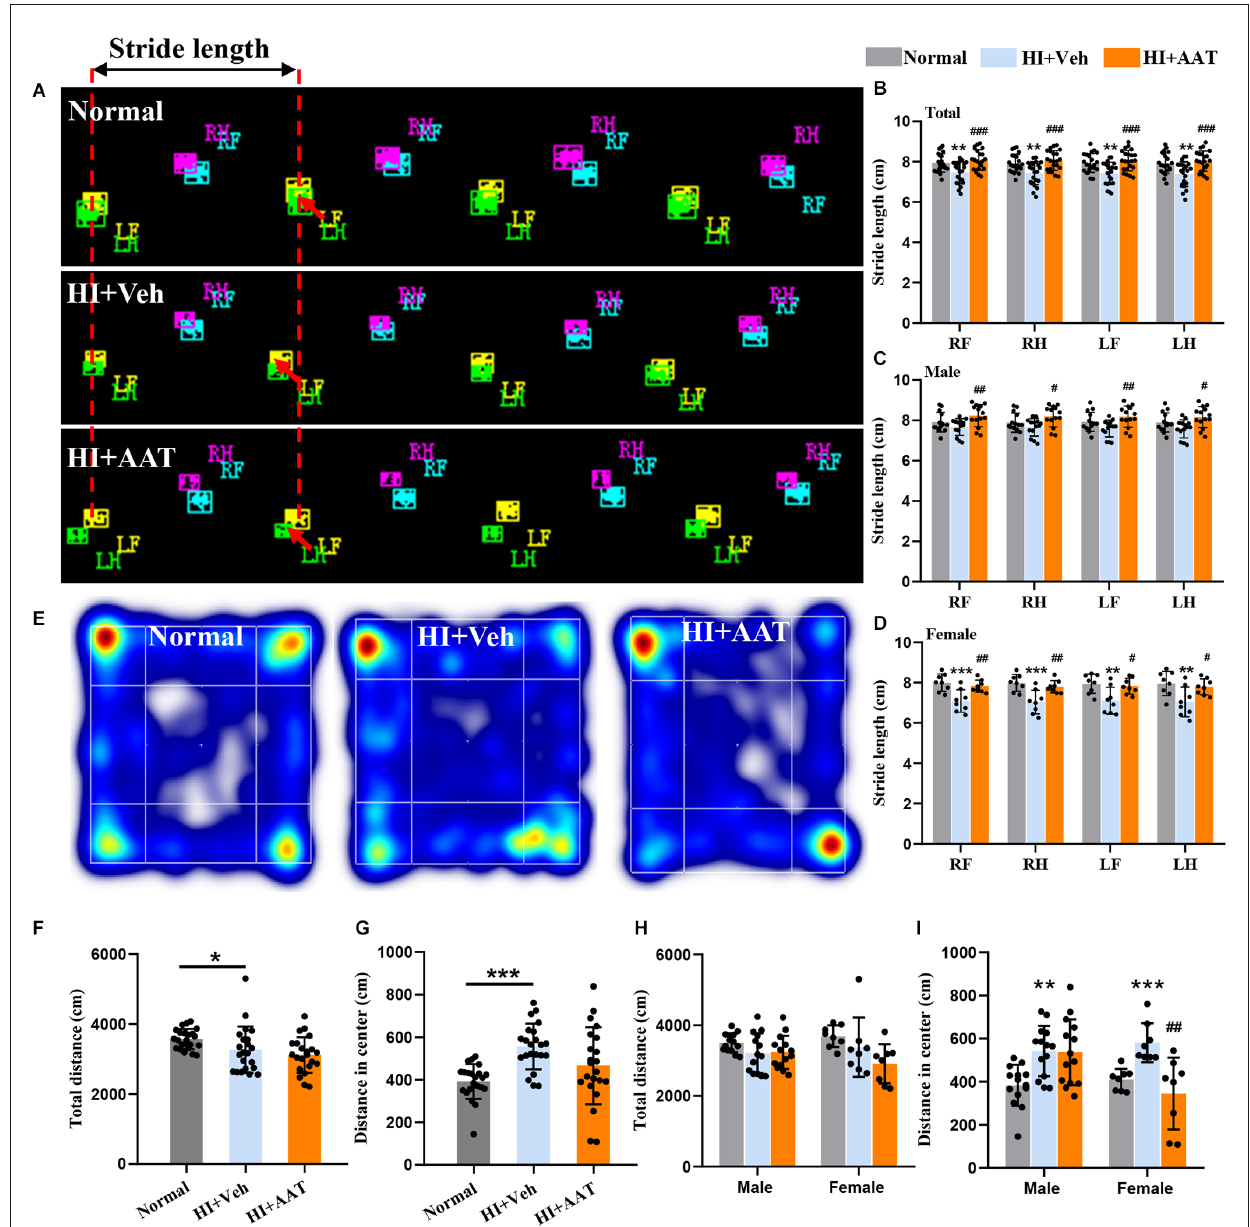
FIGURE3 Motor function deficiency and anxiety-like behaviors in neonatal HI mice after AAT treatment. (A) Graphical representation of stride length in the normal, vehicle-treated, and AAT-treated groups. RF: right front paw; RH: right hind paw; LF: left front paw; LH: left hind paw. (B) Analysis of stride length of four paws in three groups [ n = 22/group, normal vs. veh (*), RF ( p = 0.007), RH ( p = 0.006), LF ( p = 0.005), LH ( p = 0.006); veh vs. AAT ( # ), RF ( p = 0.000), RH ( p = 0.000), LF ( p = 0.000), LH ( p = 0.001)]. (C) Analysis of stride length of four paws in male mice [ n = 14/group, normal vs. veh (*), RF ( p = 0.538), RH ( p = 0.592), LF ( p = 0.25), LH ( p = 0.353); veh vs. AAT ( # ), RF ( p = 0.007), RH ( p = 0.01), LF ( p = 0.007), LH ( p = 0.015)]. (D) Analysis of stride length of four paws in female mice [ n = 8/group, normal vs. veh (*), RF ( p = 0.001), RH ( p = 0.000), LF ( p = 0.004), LH ( p = 0.003); veh vs. AAT ( # ), RF ( p = 0.009), RH ( p = 0.006), LF ( p = 0.017), LH ( p = 0.018)]. (E) Representative heat map of locomotion in normal, vehicle-treated, and AAT-treated mice. (F) Analysis of the total distance in the open field in the three groups ( n = 22/group, normal vs. veh (*), p = 0.018; veh vs. AAT ( # ), p = 0.589). (G) Analysis of distance traveled in the center area in the three groups ( n = 22/group, normal vs. veh (*), p = 0.000; veh vs. AAT ( # ), p = 0.054). (H) Analysis of the total distance in the open field in male and female mice ( n = 14/group for males, normal vs. veh (*), p = 0.397; veh vs. AAT ( # ), p = 1.000; n = 8/group for females, normal vs. veh (*), p = 0.676; veh vs. AAT ( # ), p = 0.22). (I) Analysis of distance traveled in the center area in male and female mice ( n = 14/group, normal vs. veh (*), p = 0.005; veh vs. AAT ( # ), p = 1.000; n = 8/group for females, normal vs. veh (*), p = 0.001; veh vs. AAT ( # ), p = 0.003). * p < 0.05, ** p < 0.01, *** p < 0.001; # p < 0.05, ## p < 0.01, ### p <